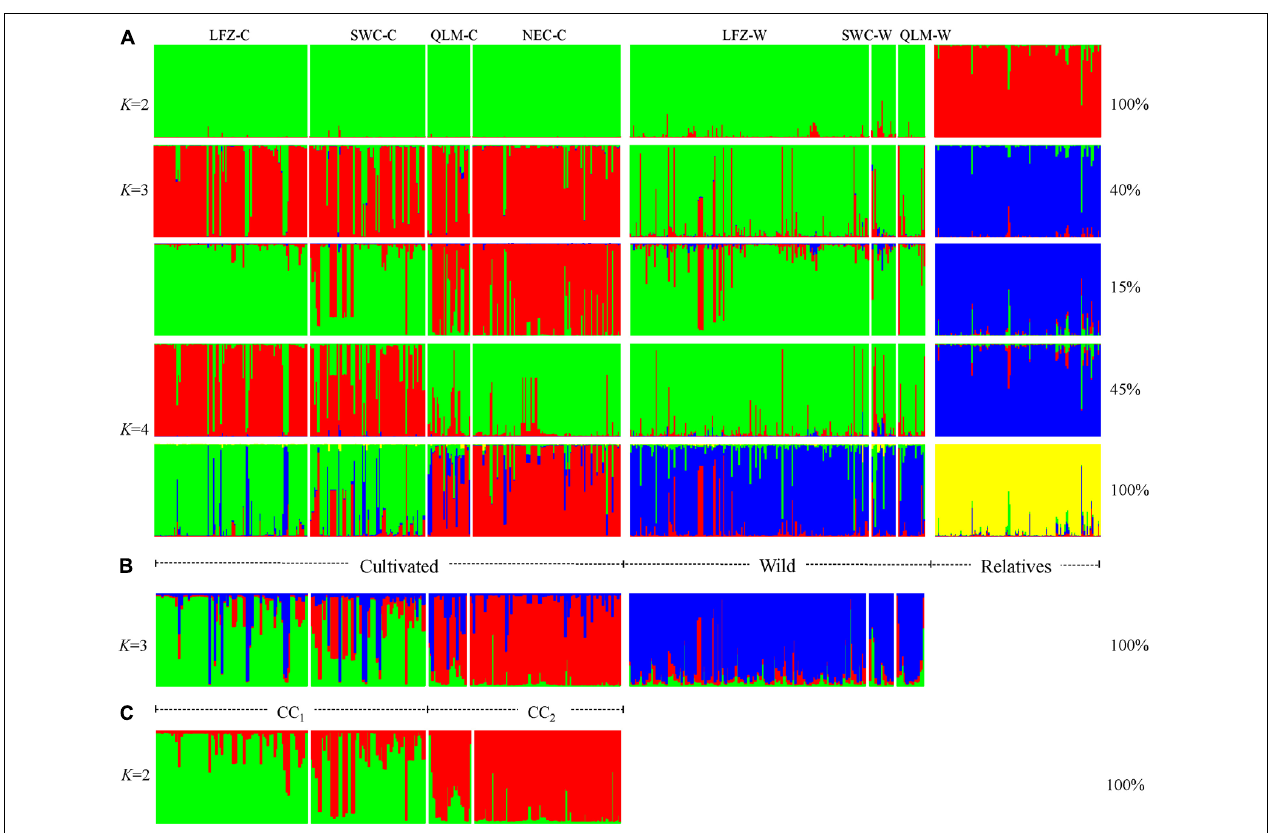
FIGURE 2 | The results of STRUCTURE analyses under (A) full dataset ( N = 650), (B) Chinese cherry dataset ( N = 532), and (C) cultivated dataset ( N = 326). A vertical line represents an individual. The x -axis shows different populations, putative status of the samples (cultivated, wild or Cerasus relative), and genetic clusters. The proportion of each simulation represents by each mode is